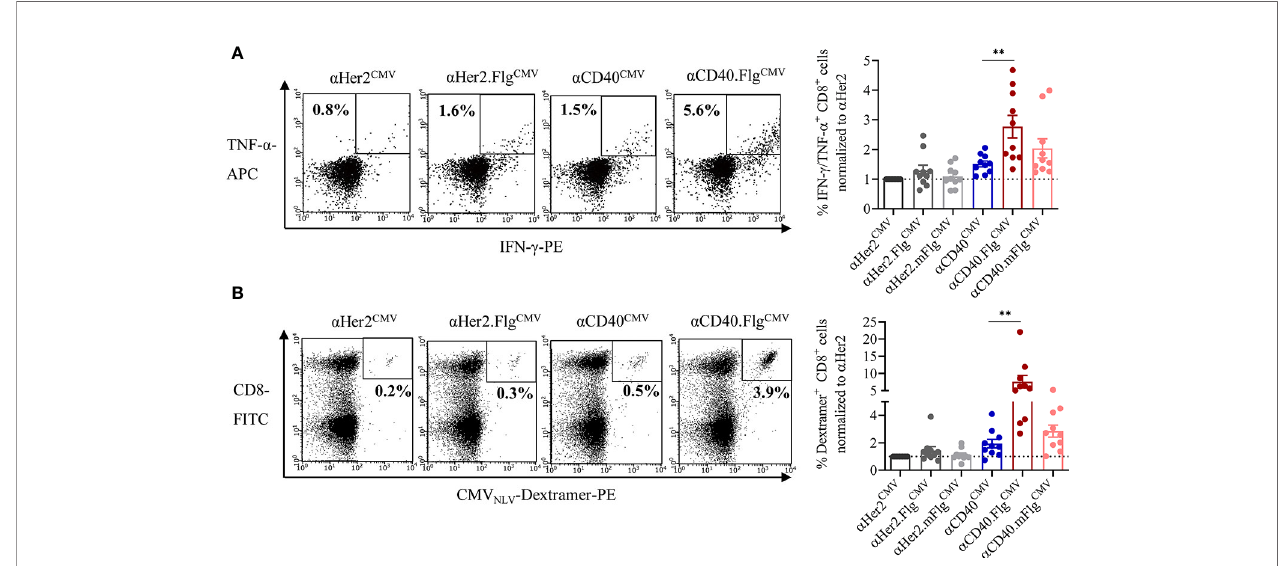
FIGURE 5 | Flagellin fusion signi fi cantly enhanced CMV-speci fi c T cell activation and proliferation. (A) Allogeneic DC – T cell co-culture of expanded and pre-activated CMV NLV -speci fi c T cells and HLA-A*02:01 + iDCs. DCs were pre-incubated with a Her2.Flg CMV , a CD40.Flg CMV and controls with mutated or no fl agellin. As readout for T cell activation, IFN- g -and TNF- a -producing CD8 + T cells was counted by fl ow cytometry ( n = 10 donors). (B) iDCs of an HLA-A*02:01 + and CMV + donor were pre-incubated with a CD40 CMV , a CD40.Flg CMV , and a CD40.mFlg CMV or the respective a Her2 controls and subsequently co-cultivated with autologous NACs. As a readout for T cell proliferation, CMV NLV -speci fi c dextramer staining was performed and analyzed by fl ow cytometry ( n = 10 donors). T cell activation and proliferation are normalized to the a Her2 control for each donor, respectively. Bars represent mean ± SEM. For statistical analysis, a Wilcoxon-signed rank test was applied. ** p <